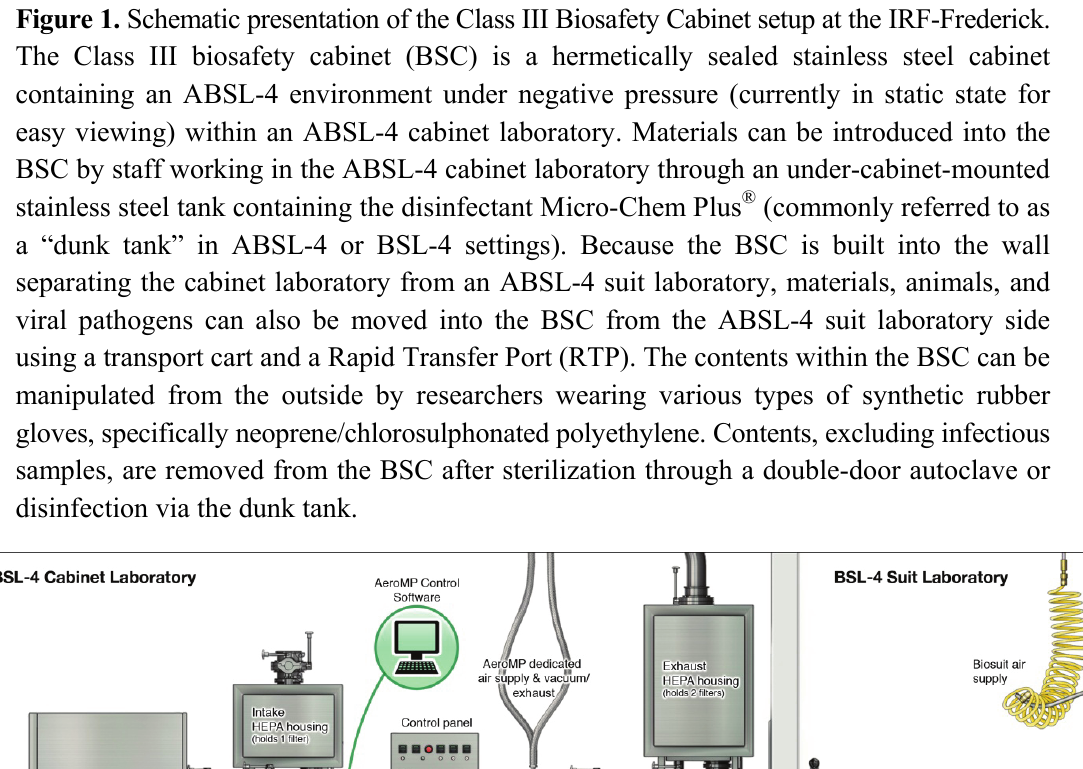
Figure 1. Schematic presentation of the Class III Biosafety Cabinet setup at the